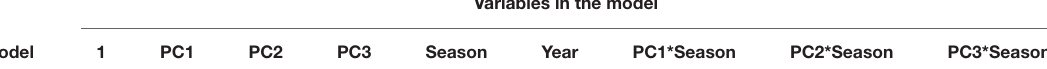
Variables in the model